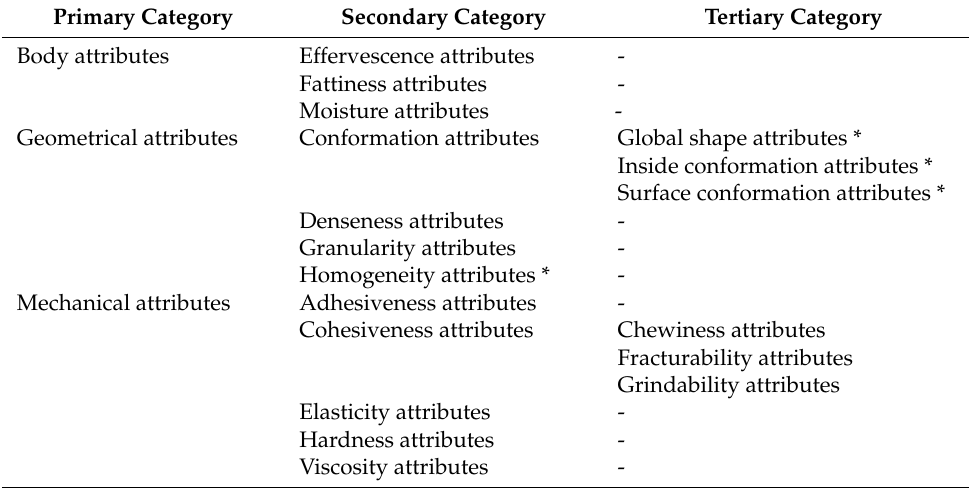
Table 3. Classification of textural characteristics inspired ISO 5492:2008 standard